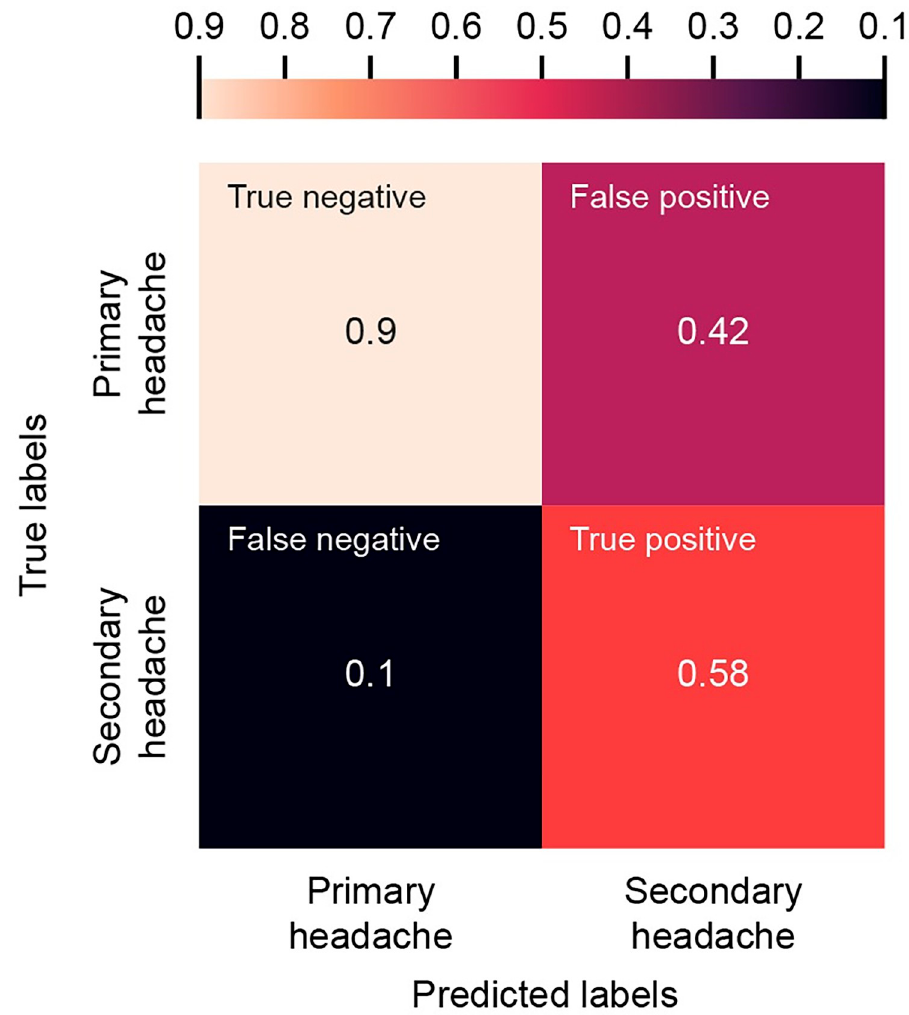
Fig 2. Confusion matrix (normalized to ratio instead of patient count) of the final prediction model on the test set using the random forest method. Features included in the model are: age group, sex, and laboratory blood test results of ten CBC parameters. CBC, complete blood